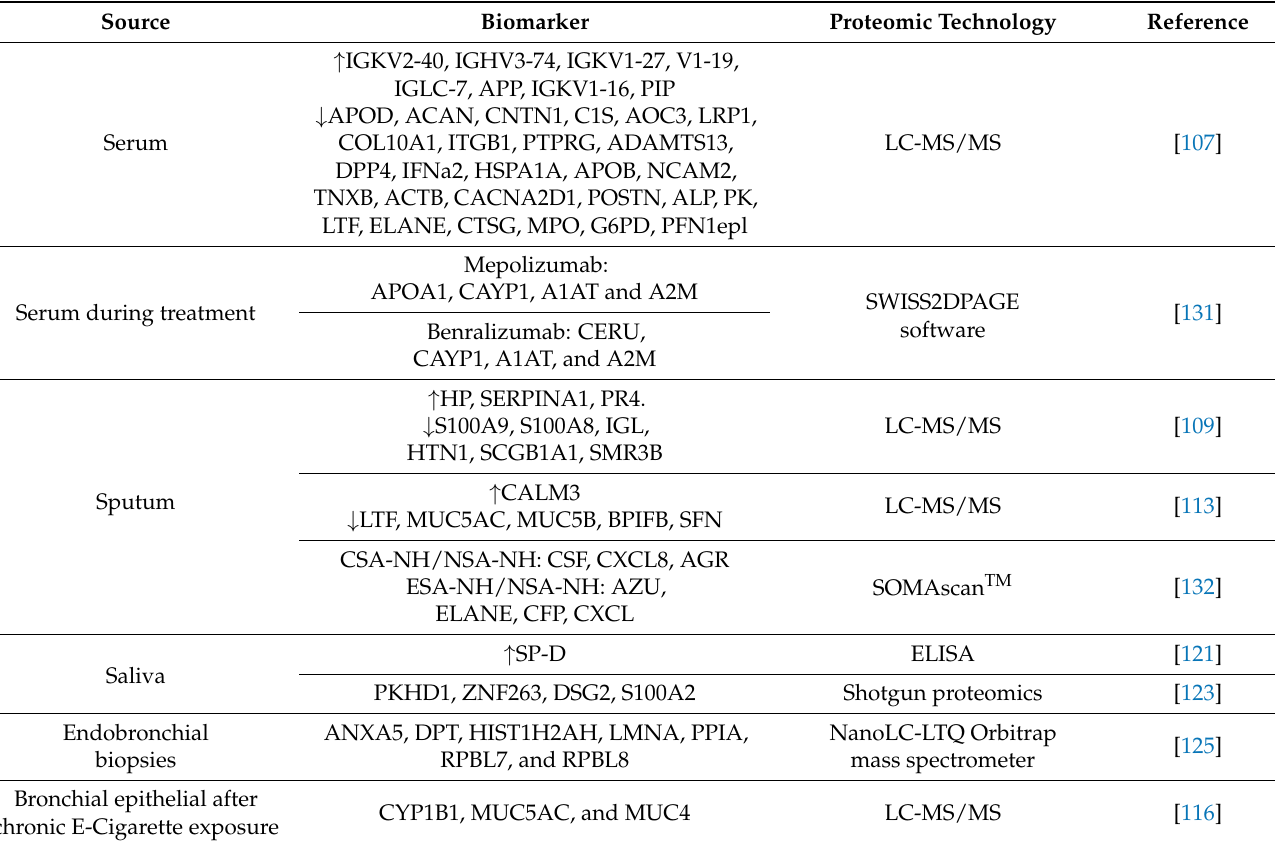
Table 4. Proteins are involved in the diagnosis and treatment of asthma. Up arrows exhibit up- regulated proteins; meanwhile, down arrows show down-regulated